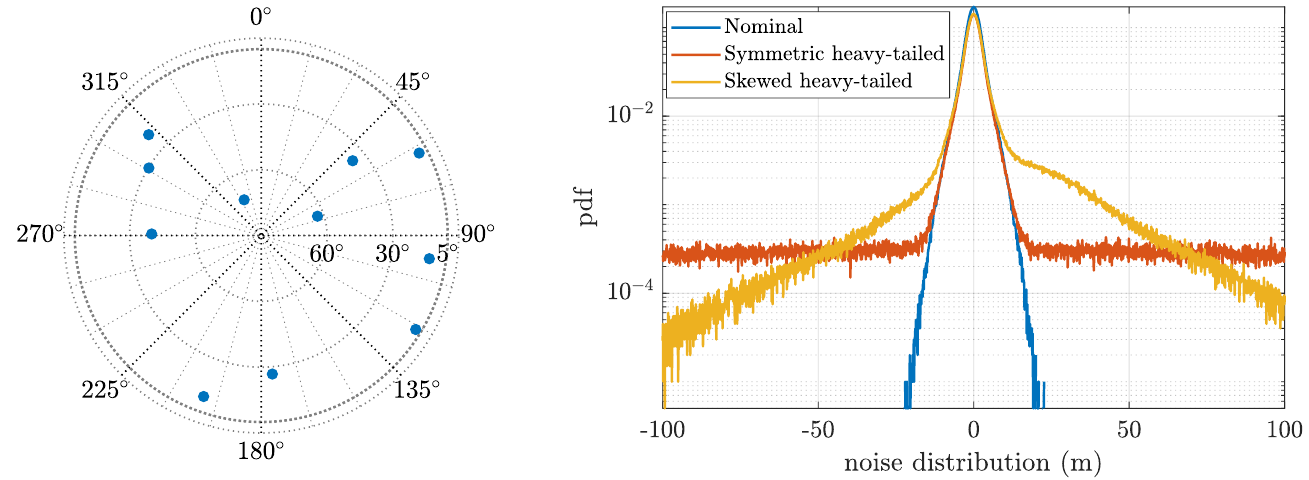
Figure 3. Skyplot and noise distributions for the different